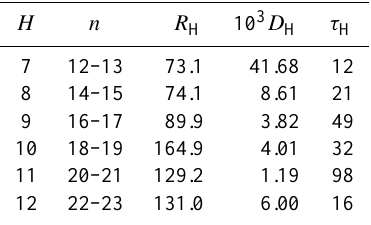
Table 3. Parameters for Hale cycles ( H